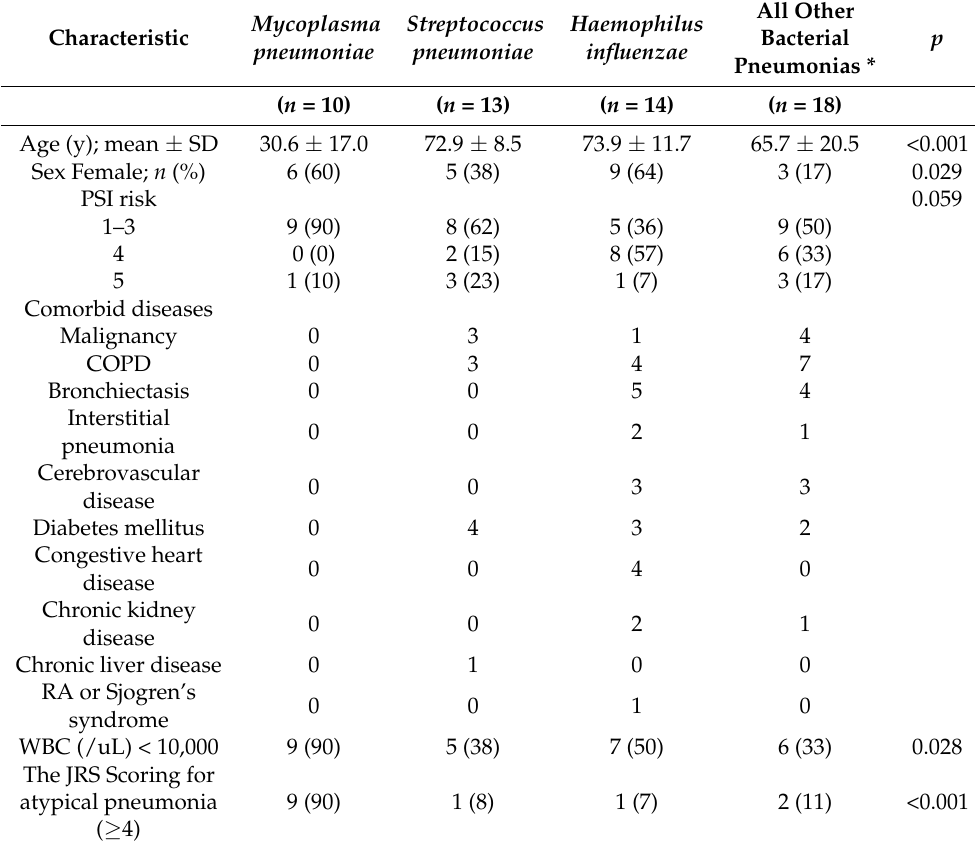
Table 1. Background characteristics of the 55 patients in this study.